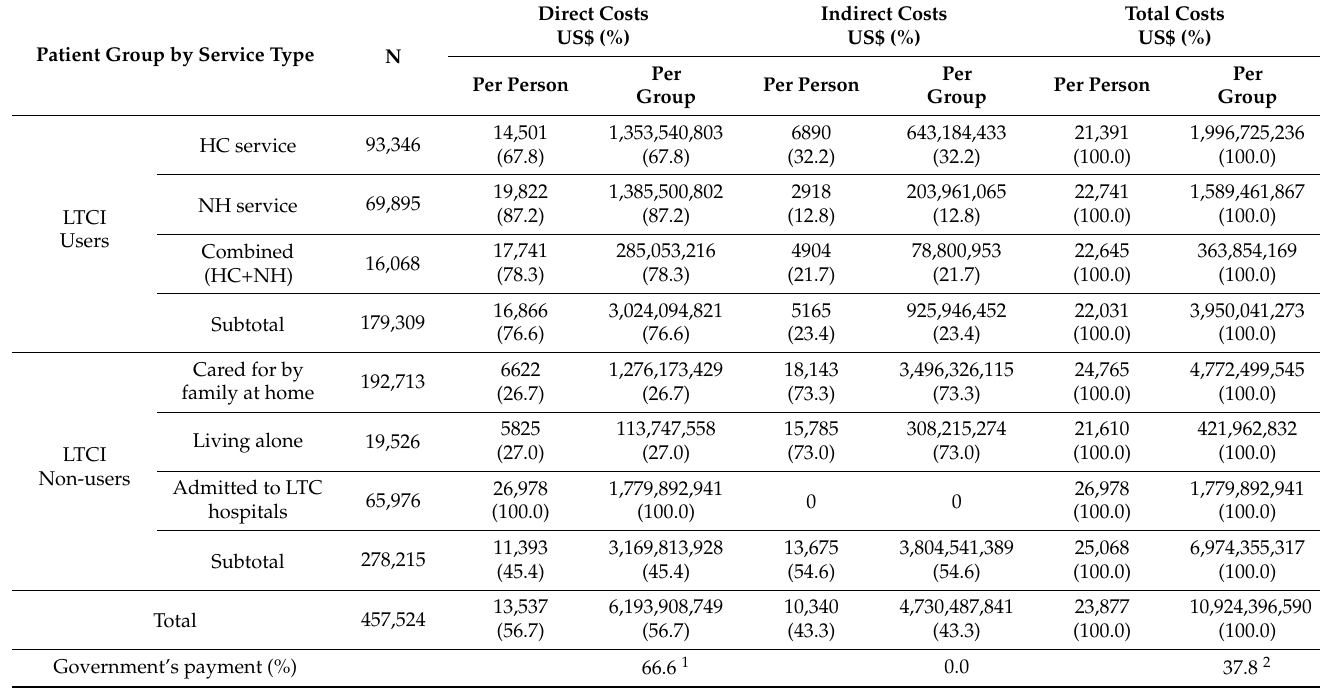
Table 2. Total Socioeconomic Costs of